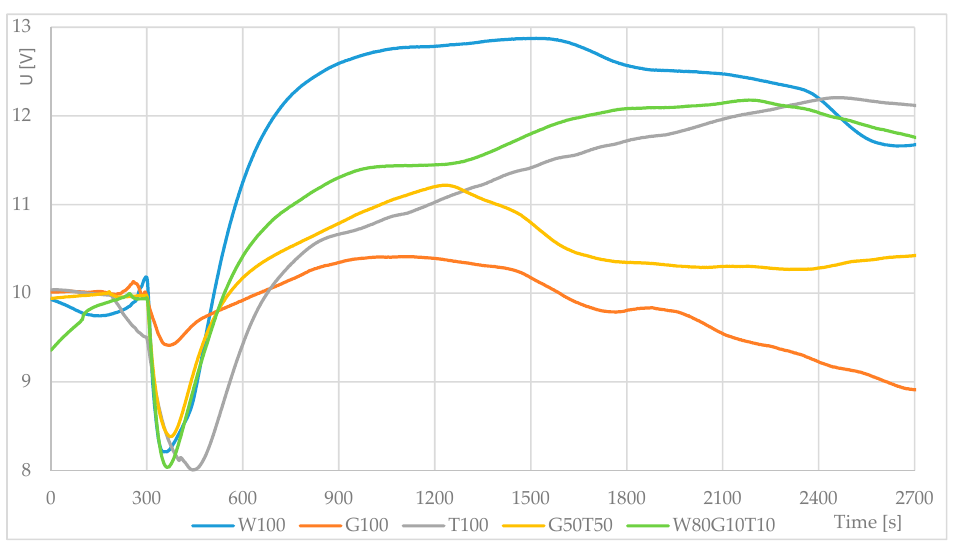
Figure 4. Fermentation process—average thermodynamic sensor response for different flour mixtures (W—wheat flour, G—grape pomace flour, T—mealworm flour). Sample inserted at t = 300 s.